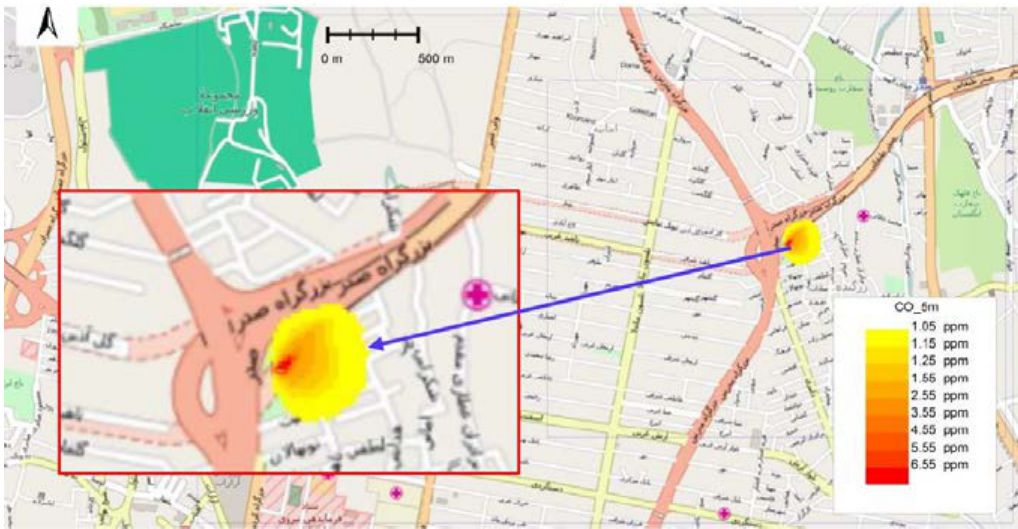
Fig. 7: Mean CO concentration at the eastern portal of the southern tunnel of the Niayesh tunnel for short-time dispersion modeling-5 m